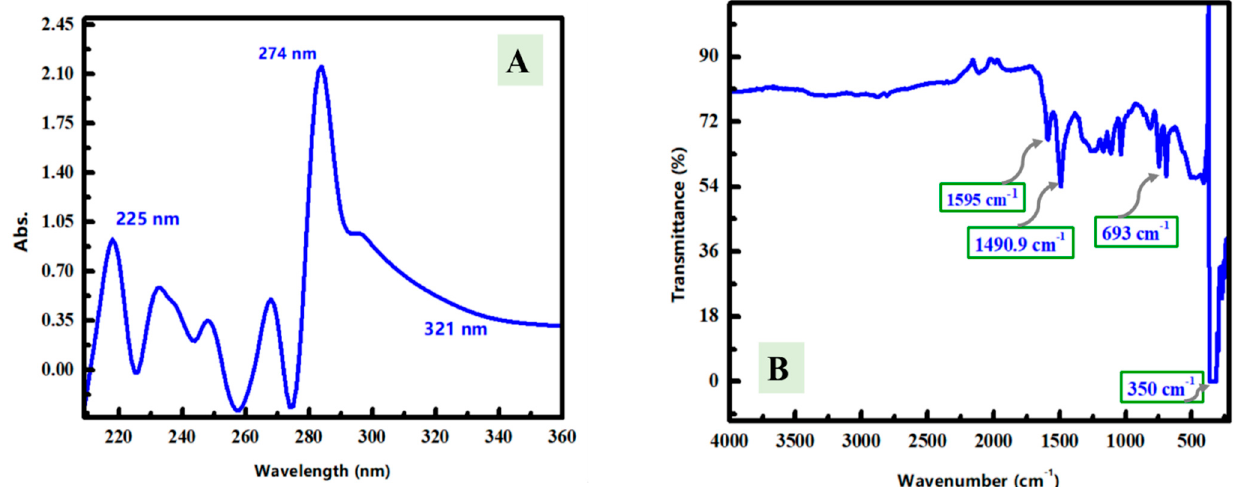
Figure 5. ( A ) UV–Visible spectroscopy of the synthesized ZnNiO@PANE composite in the corrosive medium. ( B ) FT-IR spectroscopy of the synthesized ZnNiO@PANE composite.